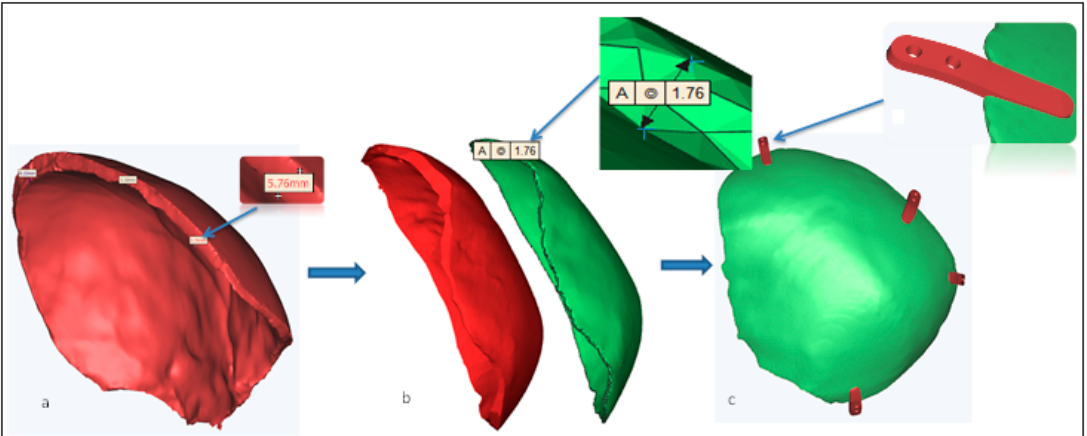
Figure 5. Thickness minimization and mini-plates attachment for fixing of screws: ( a ) Actual thickness; ( b ) Reduced thickness; ( c ) Implant fitted with mini-sheets.